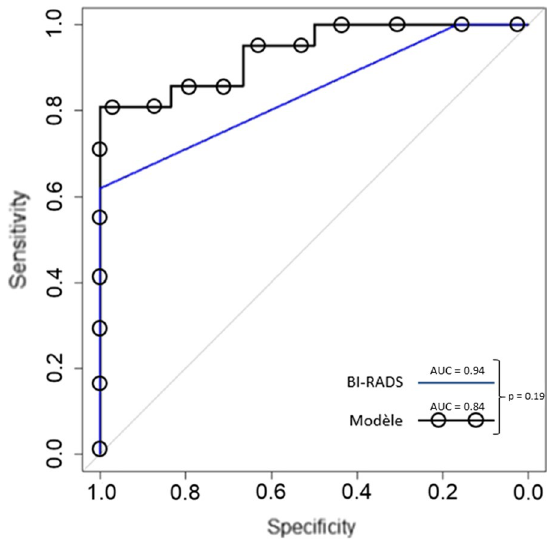
Fig. 6 ROC curve of the BI-RADS score (continuous curve) and of the radiomics model (curve with